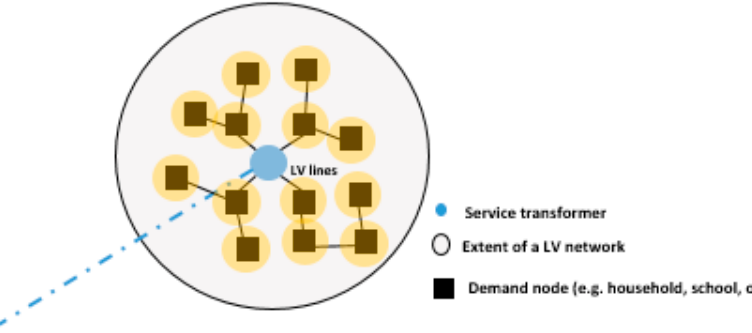
Figure A5. Sizing the LV network for each transformer in the population cluster.